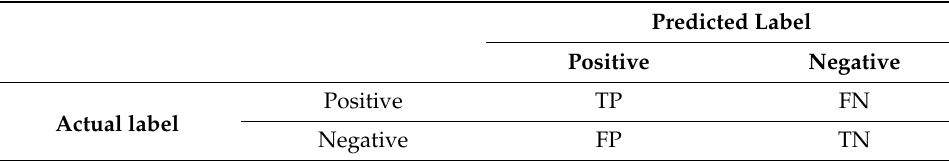
Table 1. The confusion matrix of a two-class